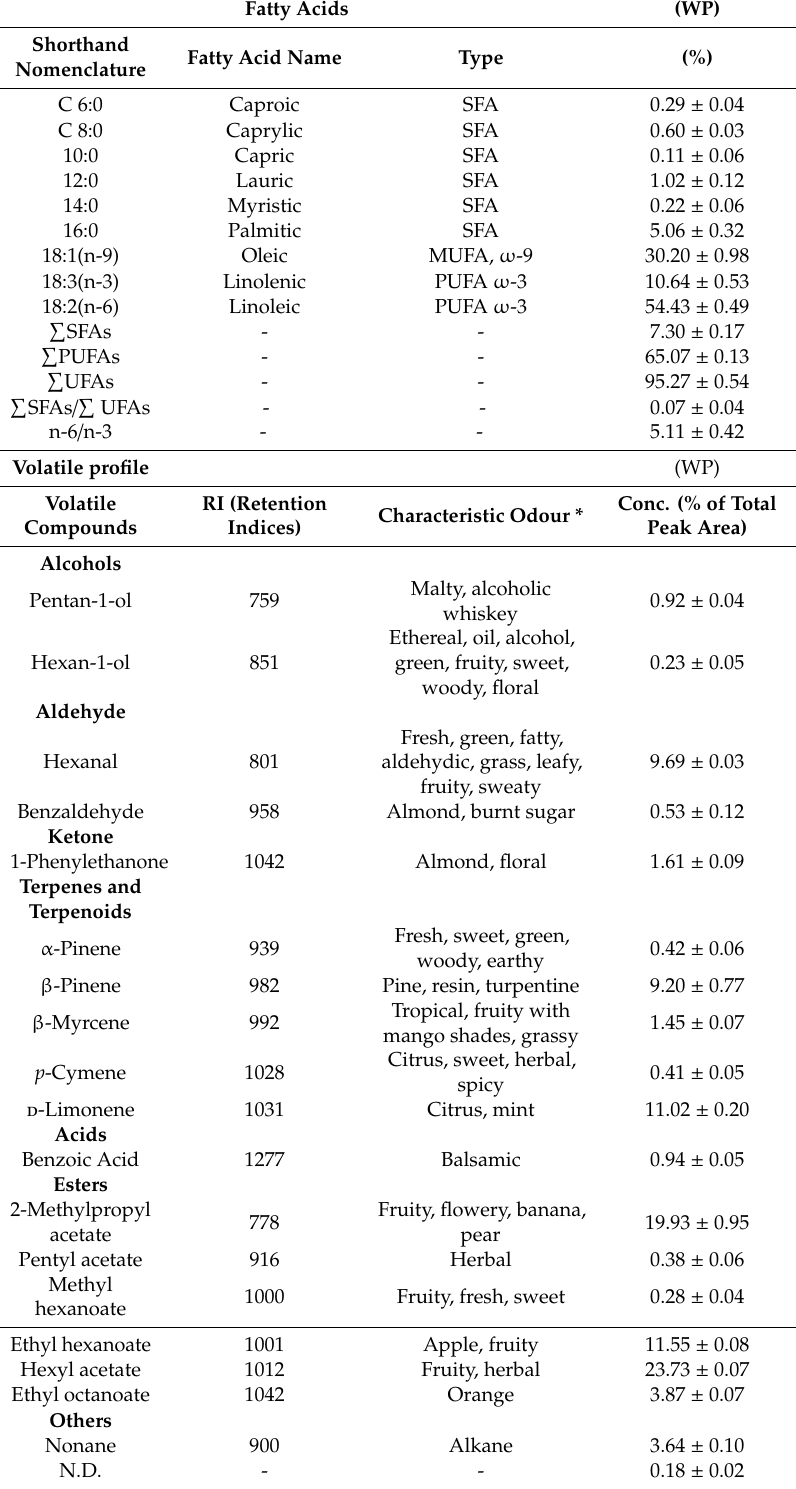
Table 2. Fatty acids and volatile profile composition of walnut oilcake powder